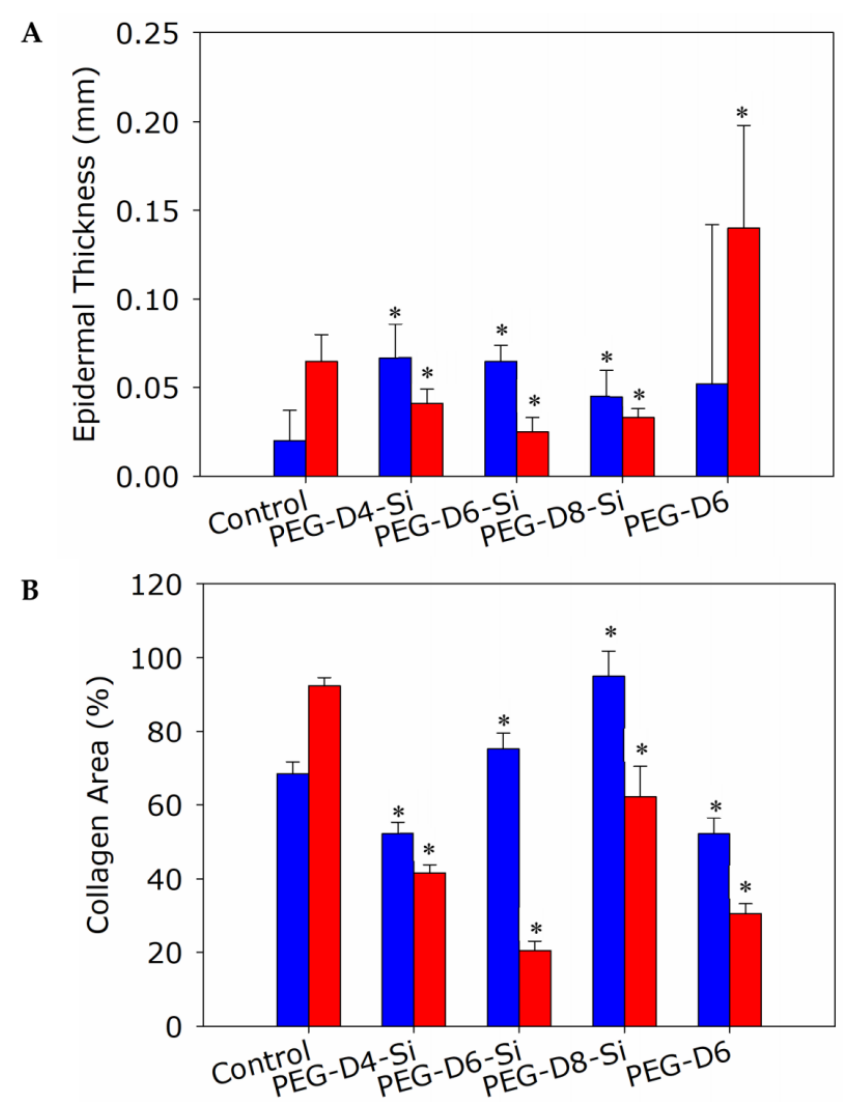
Figure 9. The epidermis thickness ( A ) and collagen content ( B ) of the wound treated with various adhesive formulations at days 7 ( (cid:4) ) and 14 ( (cid:4) ) post-surgery. Number of repeats is 3. * p < 0.05 when compared to the control at the given time point.